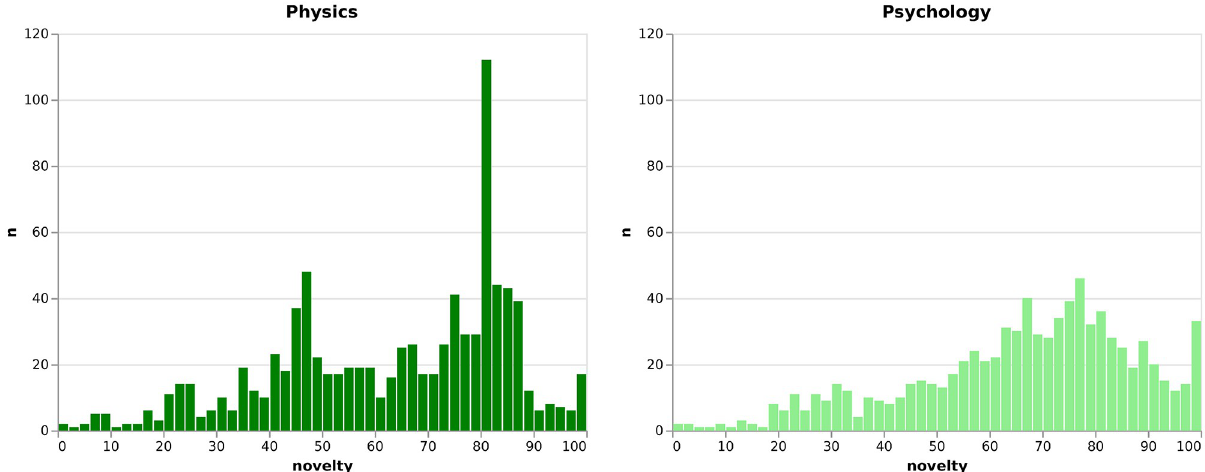
Fig 5. Novelty distribution. Distribution of the independent variable novelty for the physics and psychology